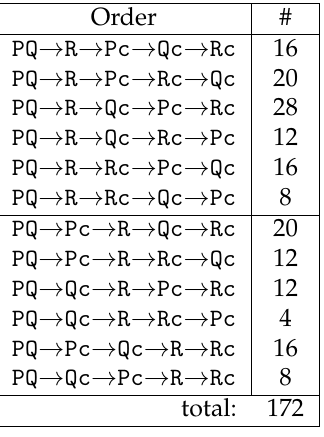
Table 5. Possible cyclic orders of points in 5-opt operations and number of different possible